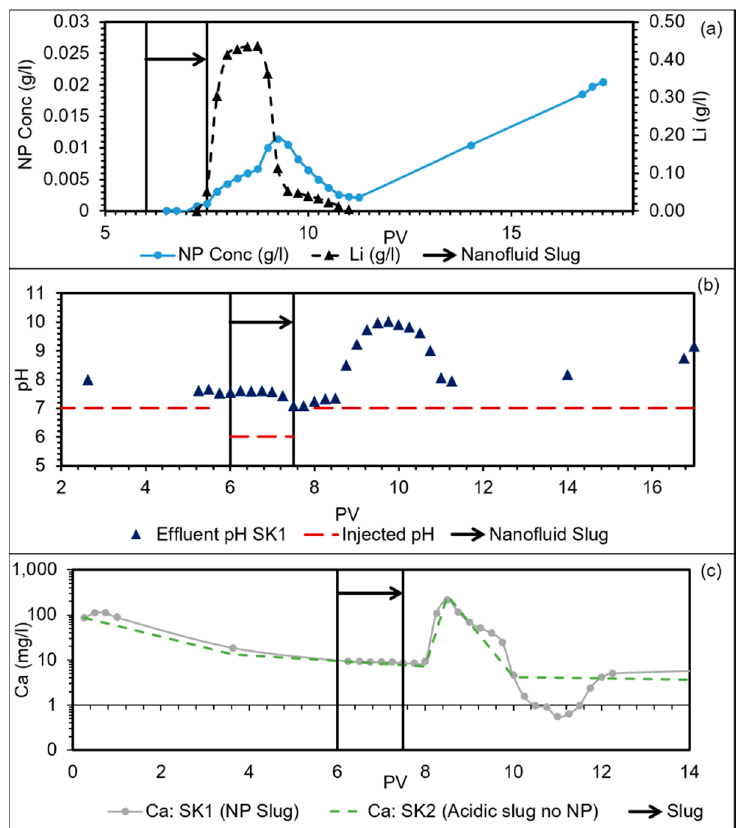
Figure 4. ( a ) NP and tracer concentration profile for SK1. ( b ) Effluent pH profile for SK1 ( c ) Effluent Ca concentration for SK1 (with NPs) and SK2 (without NPs).